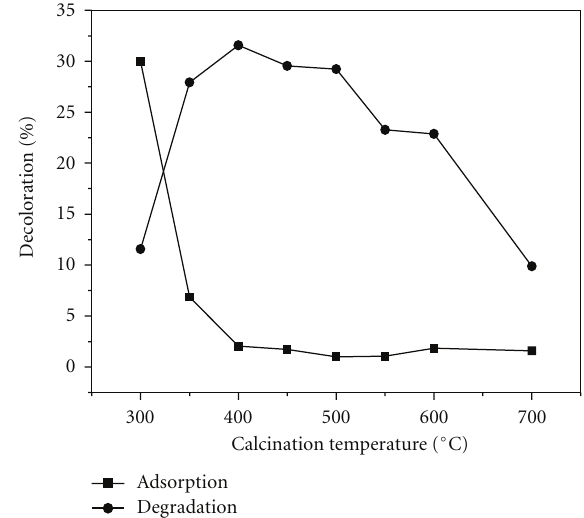
Figure 7: Photocatalytic activity of 3% B-TiO 2 sample with prolonged irradiation time.